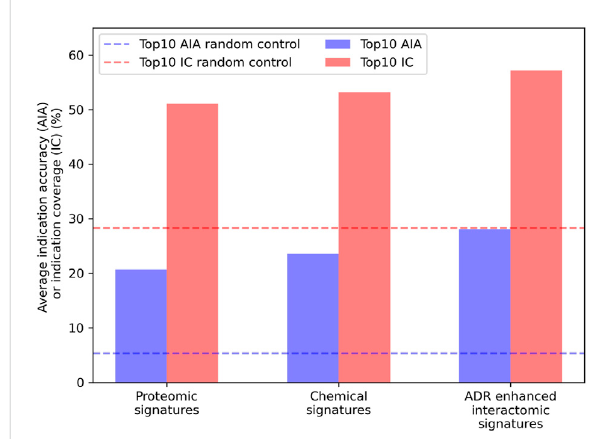
FIGURE 3 Adverse drug reaction association precision predicted from CANDO interactomic signatures. The top 100 adverse drug reaction predictions for all 12,951 compounds in the CANDO library were generated using a consensus voting scheme based on the hypergeometric distribution. Average precision was calculated at a given rank K by averaging the precision@K for all drugs with known ADRs (1171). The predictions generated using a cutoff of top 5% (647; orange) had lower average precision across all ranks compared to those generated using a cutoff of top 10% (1295; blue), yet both were 10-fold more precise on average than what is expected at random (red). The predictions using a cutoff of 25% (3,238; purple) had higher precision at early ranks, peaking at rank 10, but signi fi cantly decreased at progressive ranks. Similarly, aside from rank 1, the average precision of the top 10% lists peaked at rank 18 and steadily declined thereafter, while the top 5% lists peaked earlier at rank 12; this is likely due to the scarcity of drugs with known ADR associations in the full library (9%). Thedramaticincreaseontheexpectedaverageprecisionforallsetsof predictions indicated that the interactomic signatures captured compound behavior effectively.